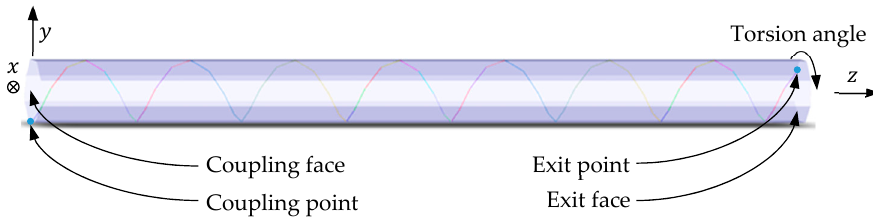
Figure 1. Spiral-shape total internal reflection of an ideal laser beam in a prism rod with eight lateral faces. Each reflection is indicated with a change of the beam color.